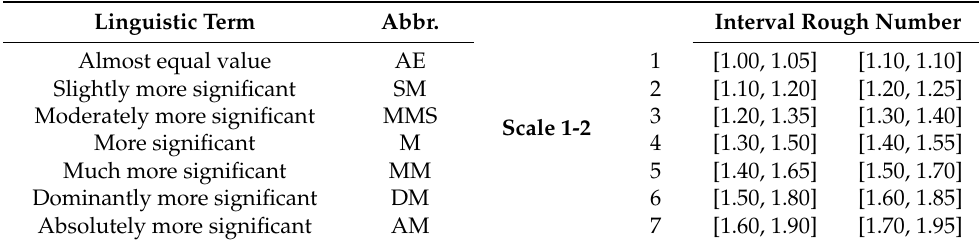
Table 1. Criterion evaluation by linguistic scale 1-2.